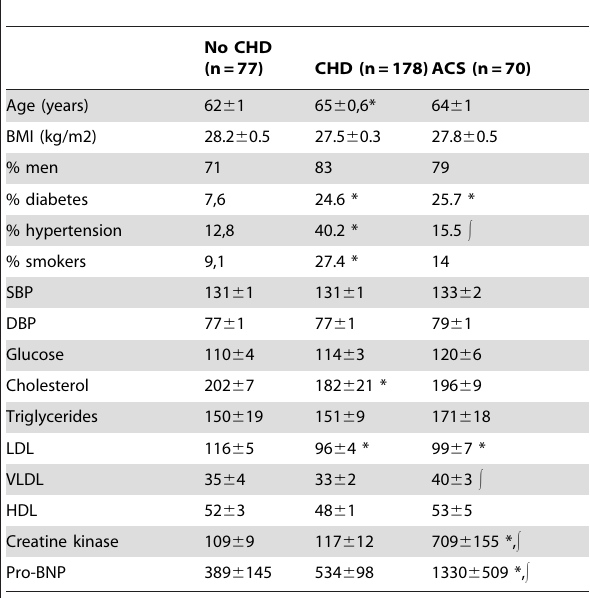
Table 2. Demographic and clinical characteristics of study